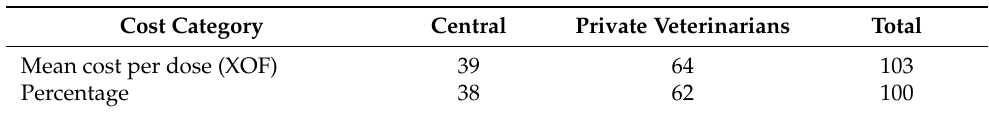
Table 5. Percentage contribution of level distribution to PPR vaccination cost in private distribution channels in Burkina Faso in